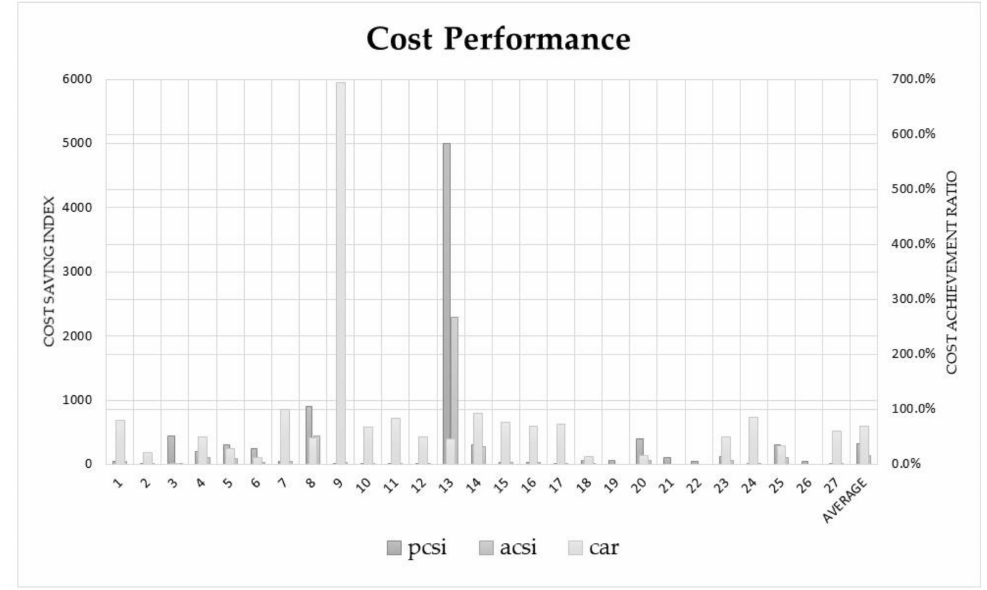
Figure 1. Cost performance of 27 projects.